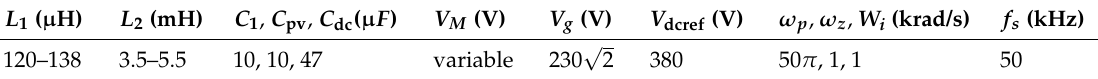
Table 3. The parameter values used for the quadratic boost converter.